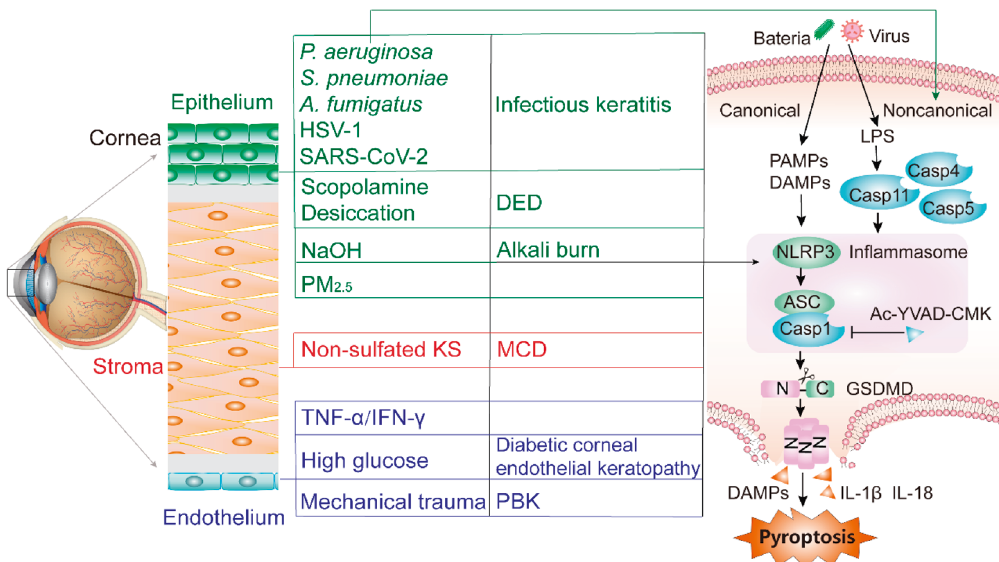
Figure 1: Schematic presentation of the potential contribution of pyroptosis to the death of corneal epithelial cells, corneal stromal cells, and corneal endothelial cells. SARS-CoV-2, severe acute respiratory syndrome coronavirus-2; DED, dry eye disease; KS, keratan sulfate; MCD, macular corneal dystrophy; PBK, pseudophakic bullous keratopathy; LPS, lipopolysaccharides; Casp, caspase; DAMPs, damage-associated molecular